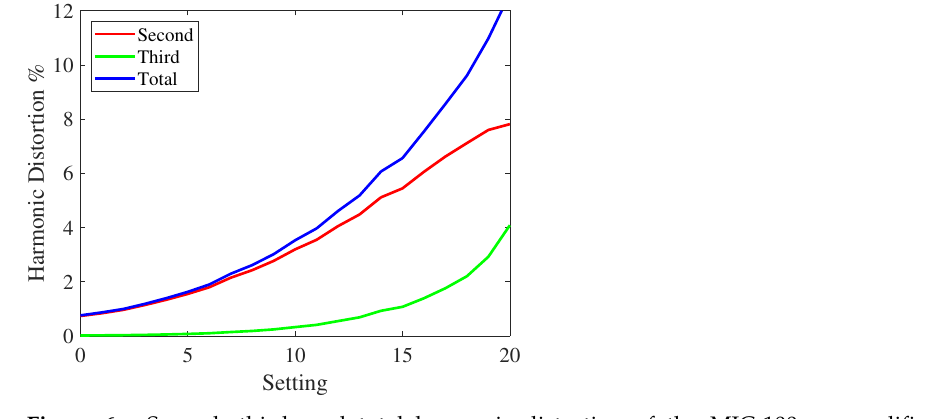
Figure 6. Second, third, and total harmonic distortion of the MIC-100 preamplifier at the different settings.